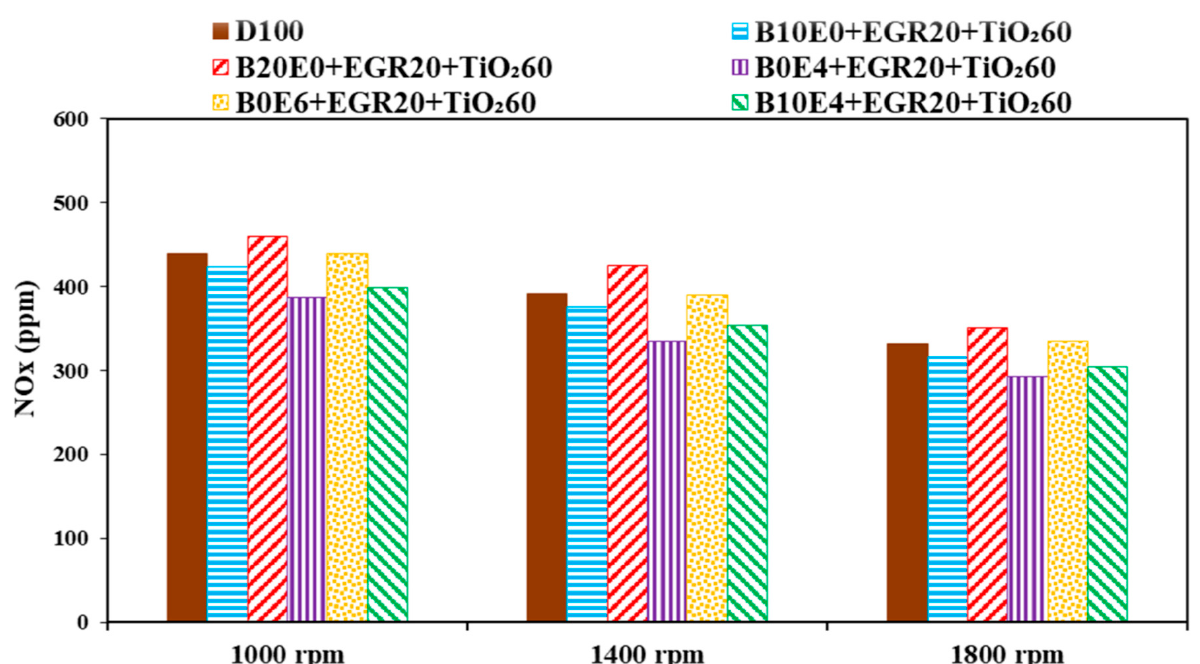
Figure 10. Variation of NO x for diesel/ethanol/biodiesel blends at TiO 2 = 40, 60 ppm, and various engine speeds.